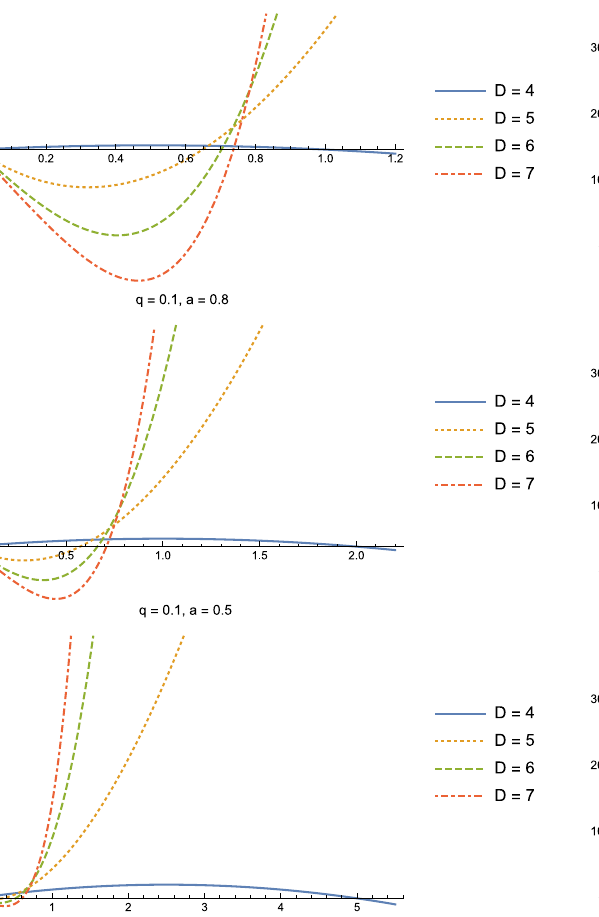
Fig. 6 Mass of black holes in D-dimensional TGR as a function of r h for different values of